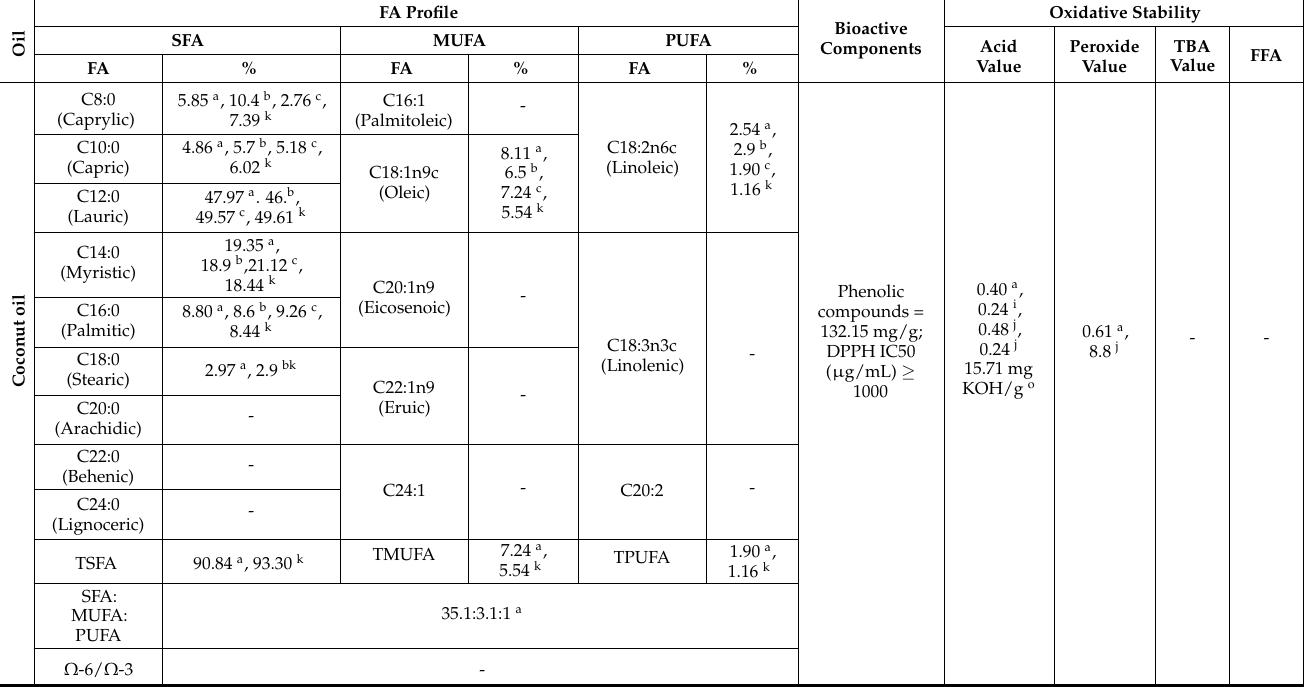
Table 1. Nutritional and physiochemical profile of selected oils (coconut oil, flaxseed oil, olive oil, sunflower oil) (a: